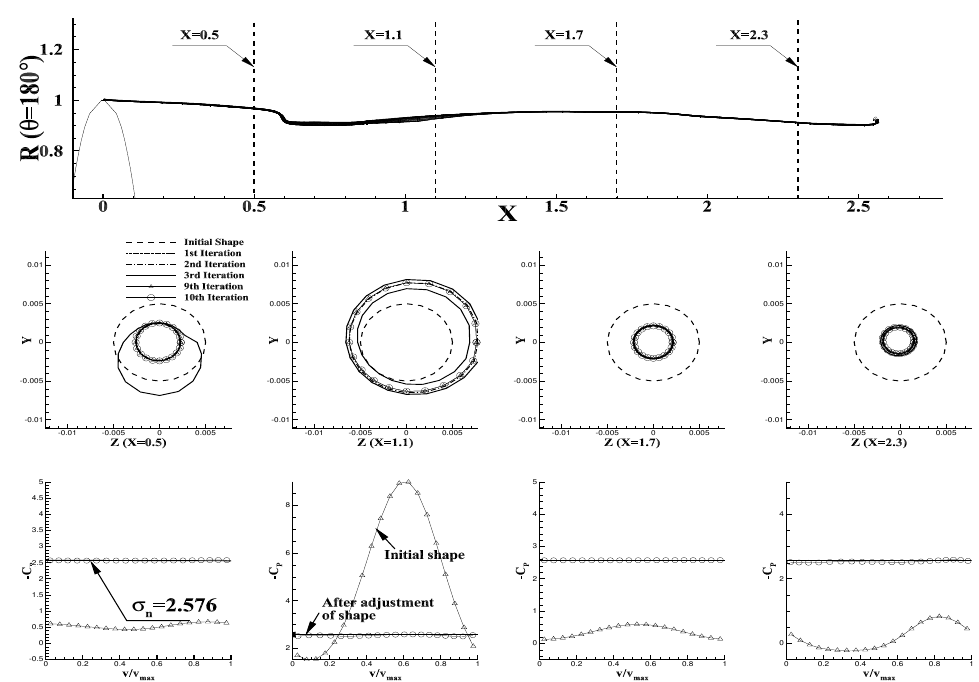
Figure 22. Projected view of the developed tip vortex cavitation from the BEM at blade angle θ = 180 ◦ on X − R plane ( up ). Convergence history of the cavitation sections at the denoted downstream locations ( middle ). Pressure distributions on the tip cavity surface at the same locations from the initial and the converged shape ( bottom ).